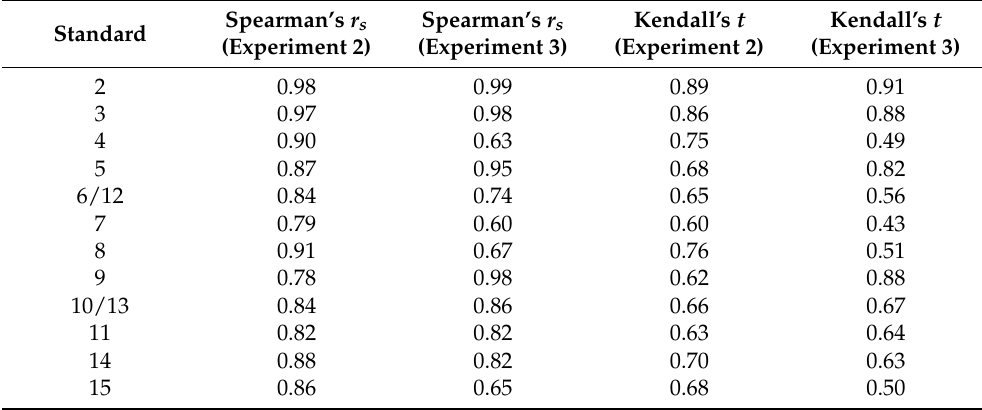
the slightly shorter experiment, even the worst standards had correlations of r s = 0.78 or t = 0.60 with the golden-standard RFIs, while for experiment 3, the values were as low as r s = 0.60 or t = 0.43. Table 8. Spearman’s and Kendall’s correlation coefficients between the gold standard (S1) and the other standards (S2–15, see Tables 2 and 3 for the details of the